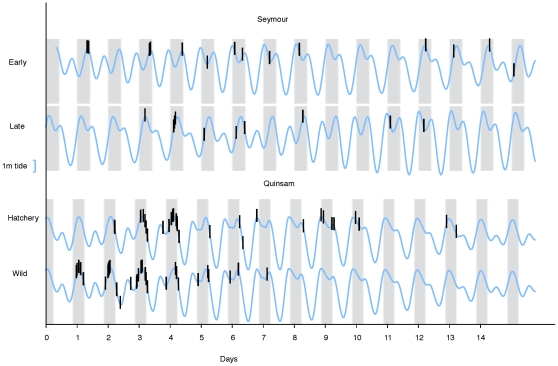
The first estuary detection of acoustically-tagged coho salmon (black bars) from the Quinsam (2006) and Seymour (2007) hatcheries.Tide height at the estuary is represented as a blue line and hours of darkness are represented by vertical gray bars. The x-origin for the two groups of Seymour coho is their release date, whereas that for the two groups of Quinsam fish is the midnight prior to the four separate release times (20 May 2006; individual release times not shown as each included both wild and hatchery fish). Not shown are five hatchery fish (three from the Seymour and two from the Quinsam) that arrived at the estuary more than two weeks after release.